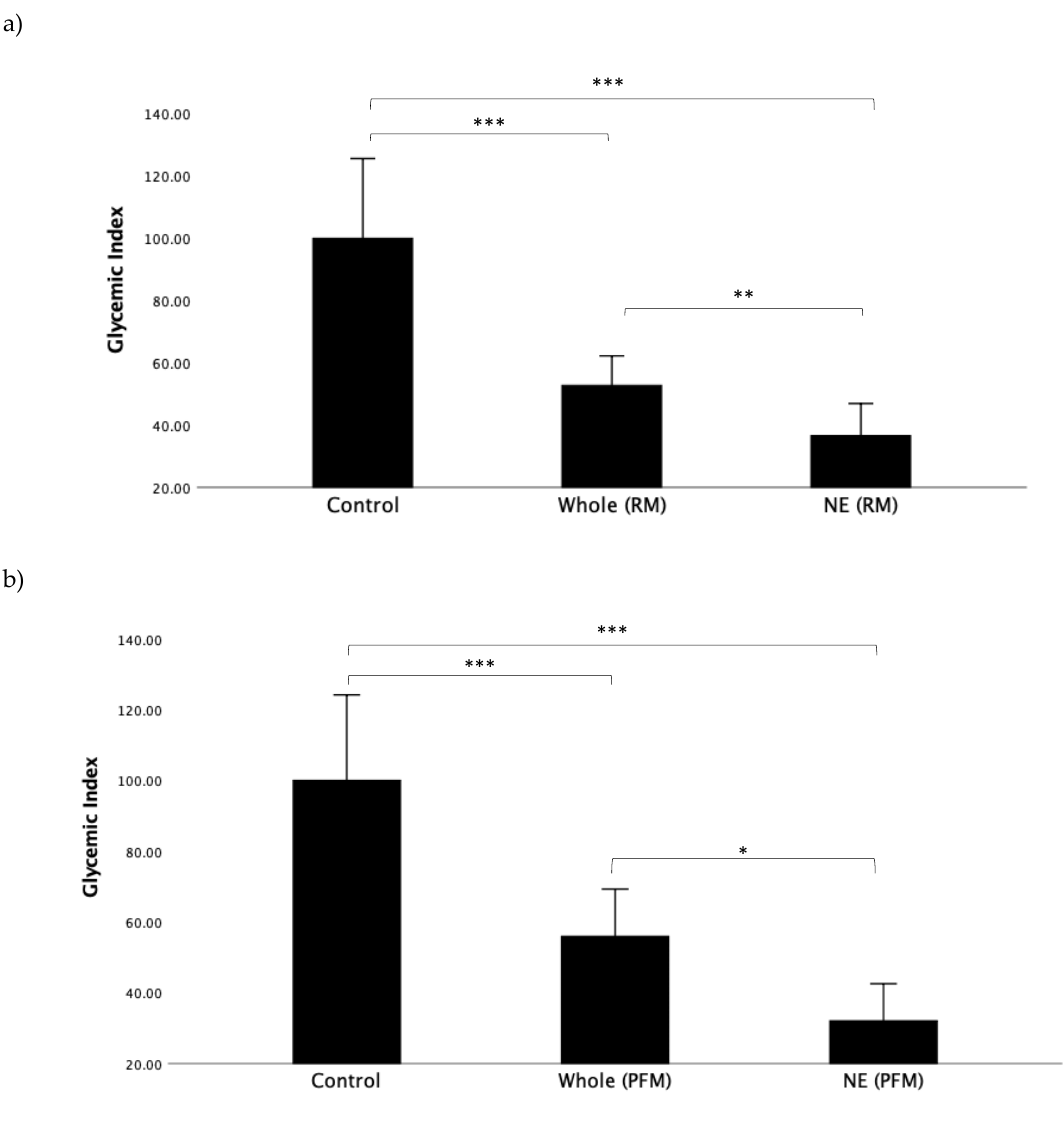
Figure 2. Comparison of glycemic index (GI) for each test meal: ( a ) raspberry and mango arm; ( b ) passionfruit and mango arm. * LSD post hoc test indicates significant di ff erent between all test * p value < 0.05, ** p ≤ 0.01, *** p ≤ 0.001